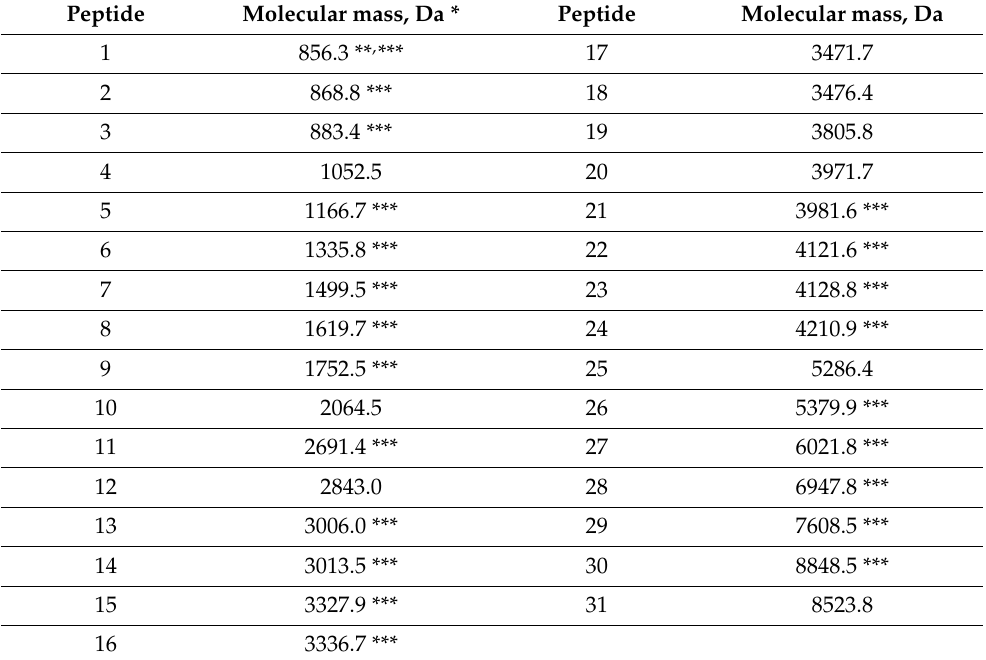
Table 1. Molecular masses of major peptides corresponding to P2 + P3 peaks of VESmix iso- lated by affinity chromatography on anti-CD9/CD63-Sepharoses and extracts obtained using TFA and acetonitrile.